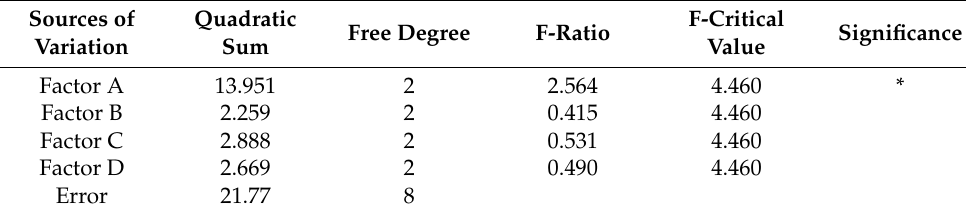
Table 8. Analysis table of variance.